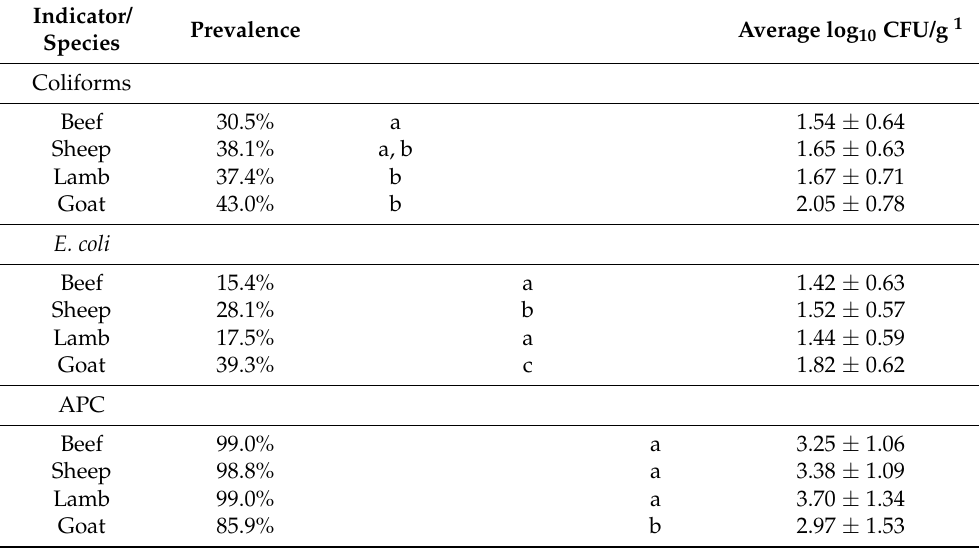
Table 2. Prevalence and level of indicator bacteria quantified on beef, sheep, lamb, and goat offal samples. Prevalence values in columns for each indicator with the same letter are not significantly different. Data presented are for both chilled and frozen samples